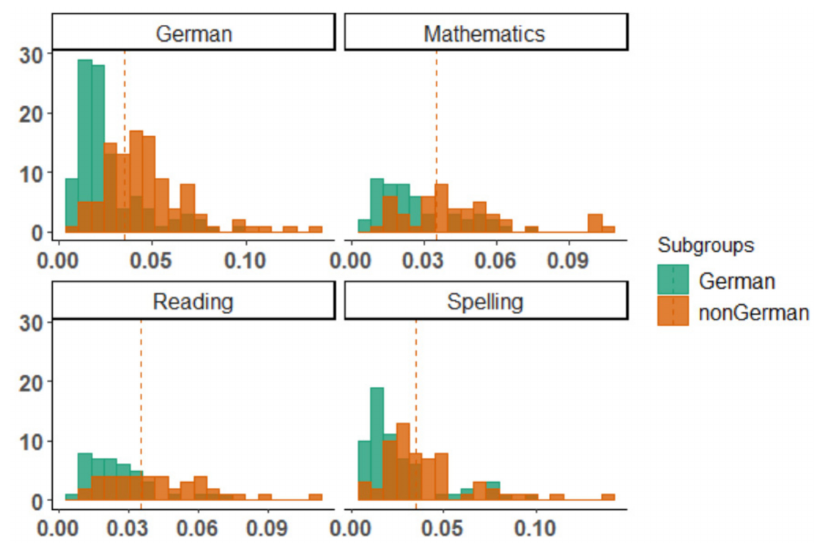
Figure 3. Empirical distribution of the RMSD for the items on the reading, spelling, German, and mathematics tests. The dotted line indicates the mean of the RMSD values for language